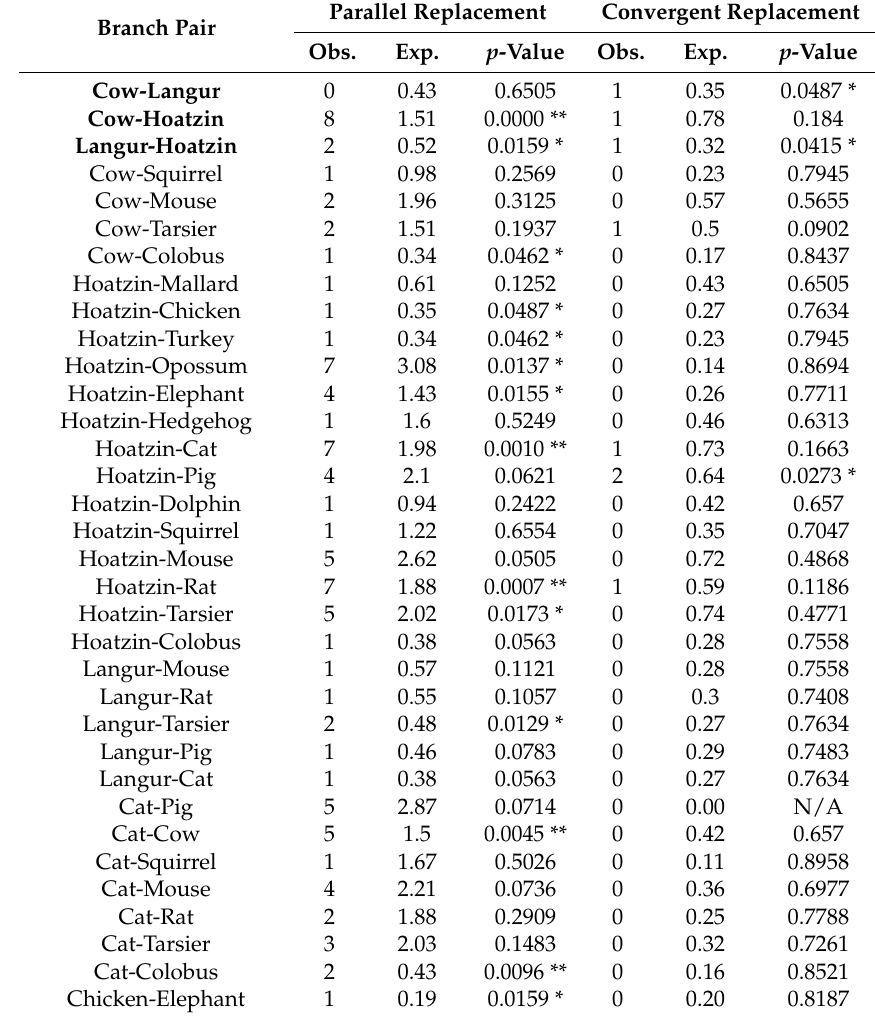
Table 2. Tests of parallel and convergent evolution of lysozyme c sequences. Each of the three branch pairs leading to two foregut fermenters is shown in bold. All other comparisons involving two terminal branches with either at least one parallel replacement or at least one convergent replacement are also listed. A statistical test is performed under the assumption that the number of parallel (or convergent) replacements for a given branch pair follows a Poisson distribution with the mean equal to the expected number. When the observed number is smaller than the expected, the lower tail is given; otherwise, the upper tail probability is given. Significant difference between the observed and expected numbers is marked with * ( p ≤ 0.05) or ** ( p ≤ 0.01). If the observed and the expected numbers of